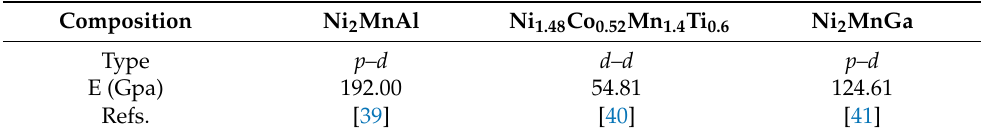
Table 2. Young’s elastic modulus E for some representative conventional ( p–d ) and all- d -metal ( d–d ) Heusler